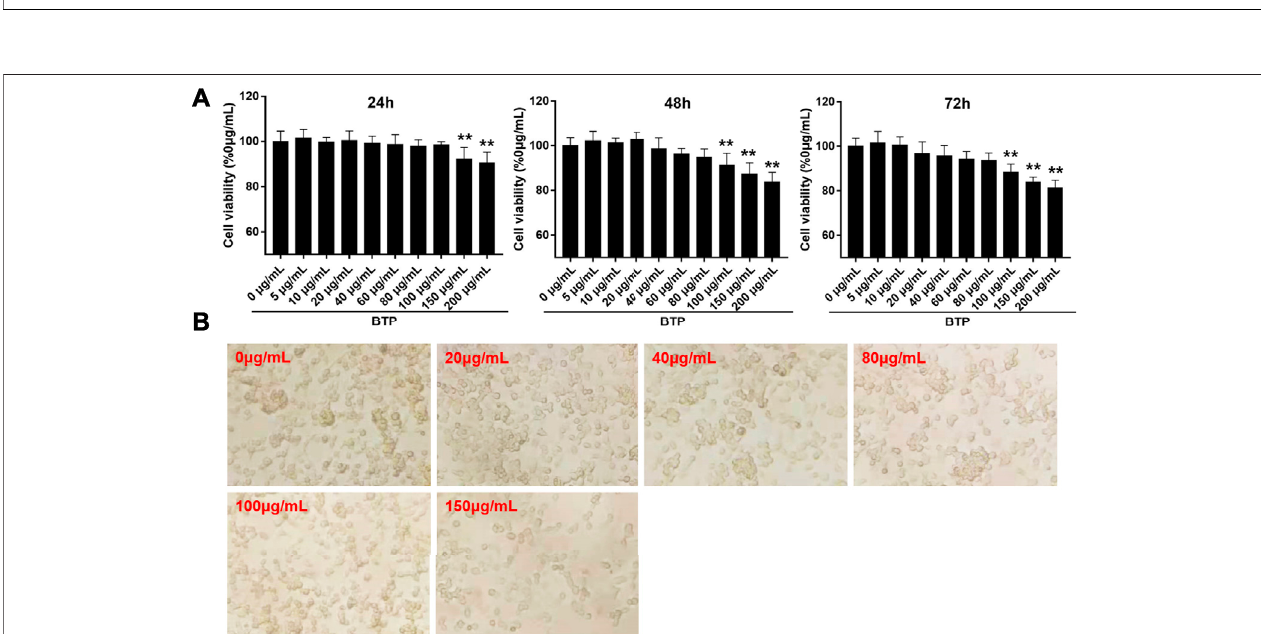
FIGURE 5 | Cytotoxic effect of BTP on RAW264.7 cells. (A) Cell viability assays of RAW 264.7 cells treated with series doses of BTP at 24, 48, and 72 h, respectively. (B) Representative fi gures of RAW264.7 cells treated with series doses of BTP for 24 h.